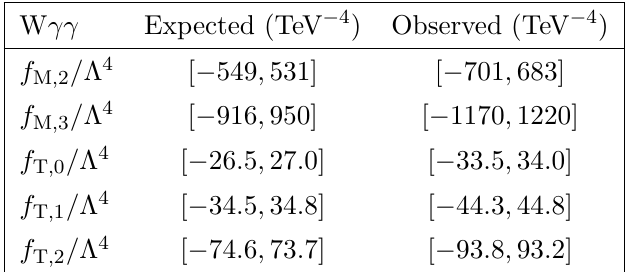
Table 5 . Expected and observed 95% CL limits on anomalous quartic gauge couplings. Limits are obtained using W (cid:13)(cid:13) events in which the leading photon p T exceeds 70 GeV.